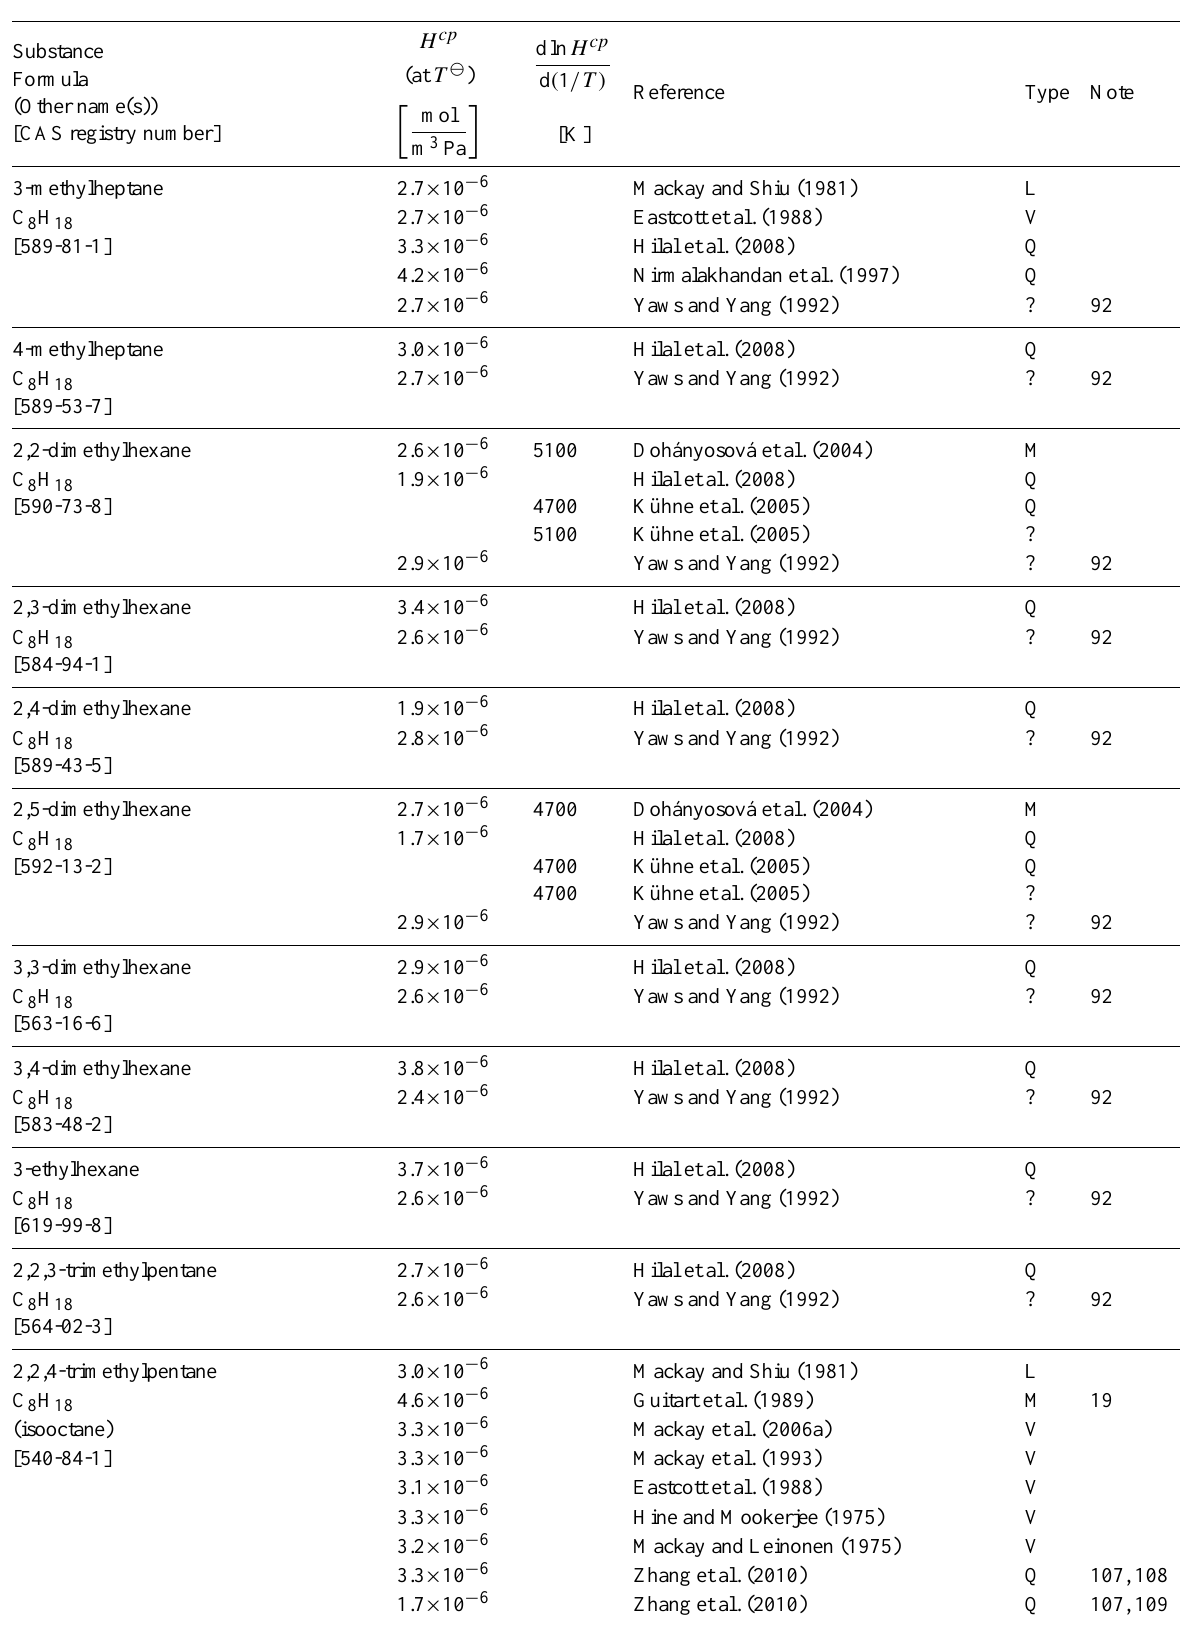
Table 6: Henry’s law constants for water as solvent